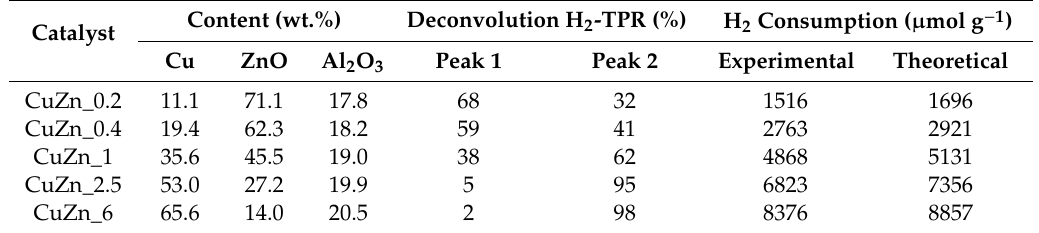
Table 1. Chemical composition and H 2 consumption of mixed metal oxides obtained by calcination of LDHs. Content (wt.%) Catalyst